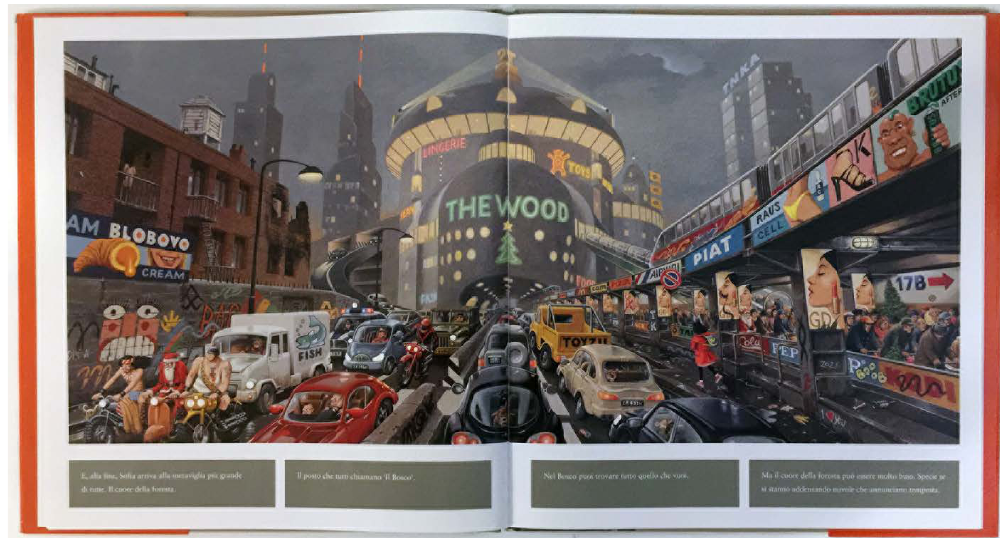
Fig. 15 Roberto Innocenti. Cappuccetto Rosso. Una fiaba moderna ,